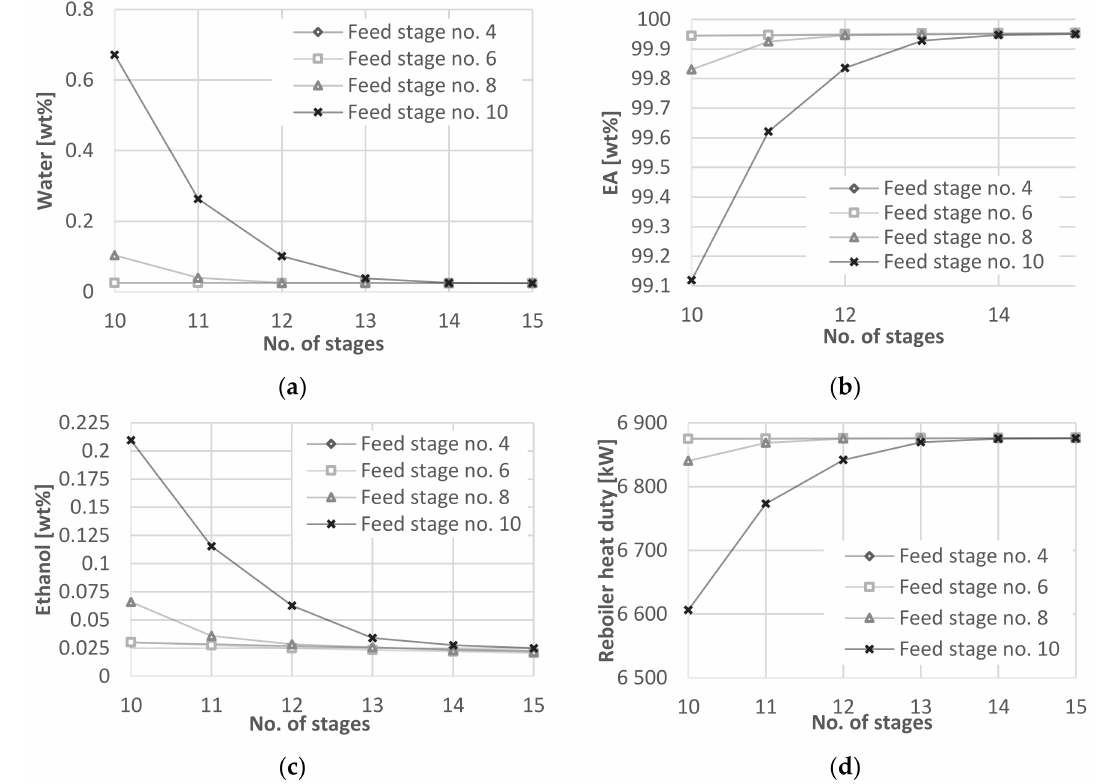
Figure 6. The impact of feed location and the number of stages on: ( a ) water content in the product; ( b ) EA content in the product; ( c ) ethanol content in the product; ( d ) evaporator